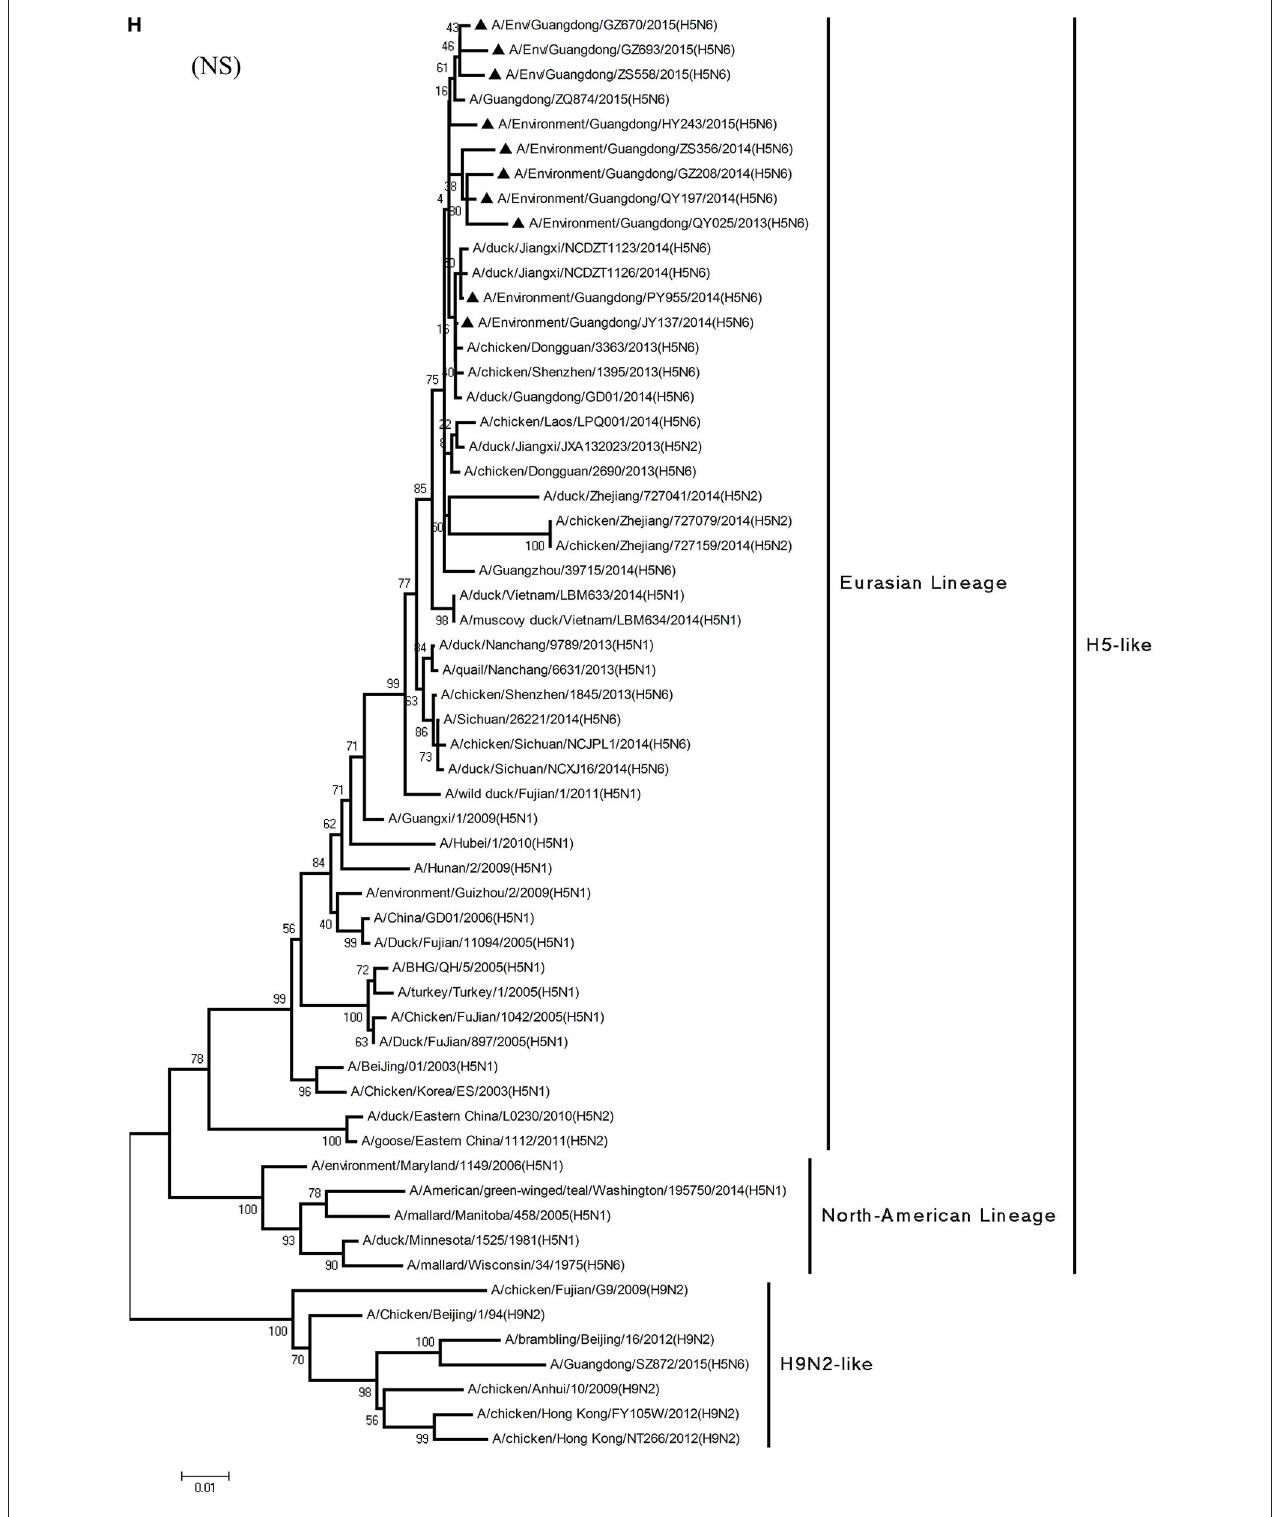
FIGURE 1 | Phylogenetic analyses of the open reading frames of H5N6-subtype avian influenza viruses. Viruses highlighted with black triangles ( N ) were characterized in the present study. The tree was constructed using the neighbor-joining of Molecular Evolutionary Genetics Analysis 6.06, with 1000 bootstrap trials to ensure confidence in the